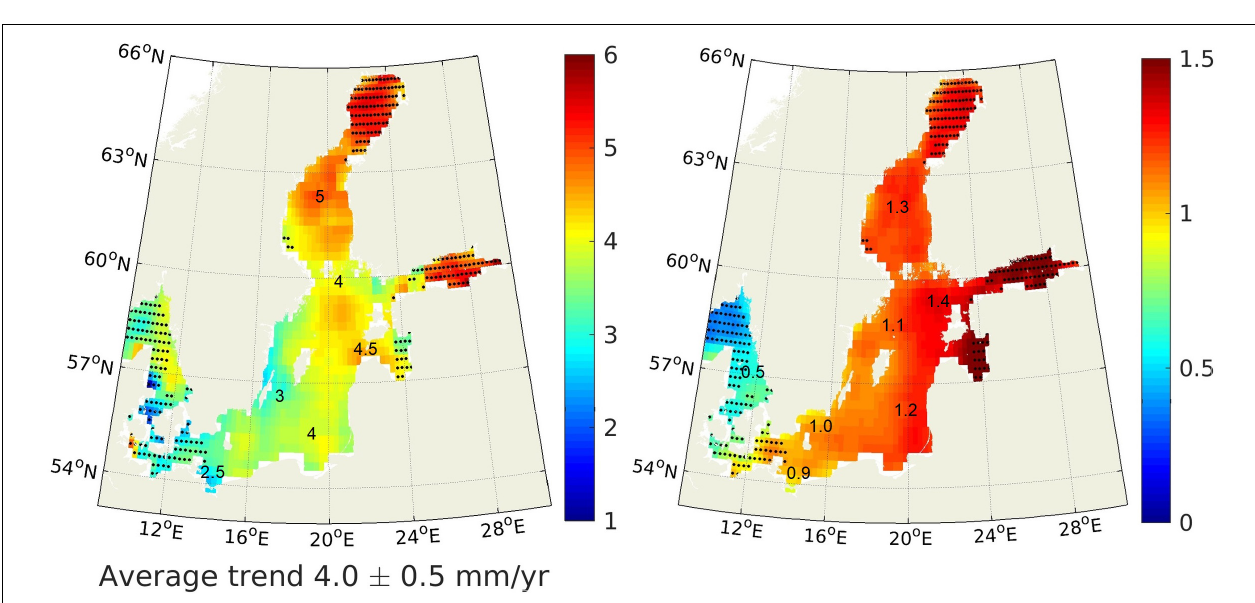
FIGURE 7 | Left: CCI data evaluation showing the areas with adequate data quality according to this study, and the areas with low correlation and/or high RMS difference to SLV_SRM (colored areas) and SLV_TG (circles). Right: percentage of areas with different quality classes versus distance to the coast.